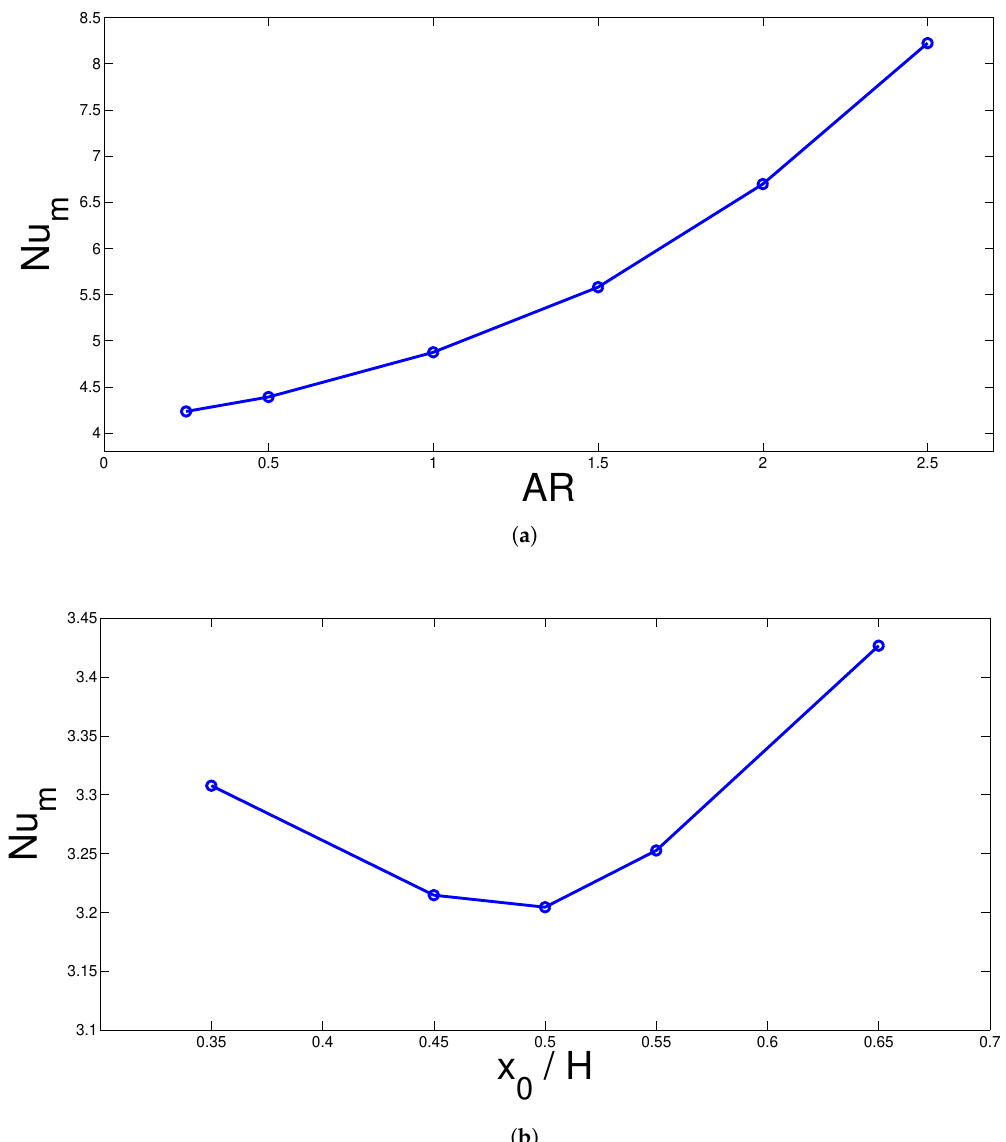
Figure 7. Effects of aspect ratio ( a ) and x-location of the rotating cone ( b ) on the variation of average Nusselt number of the hot surface (Ri = 5, Ha = 10, Da = 10 − 3 , φ =